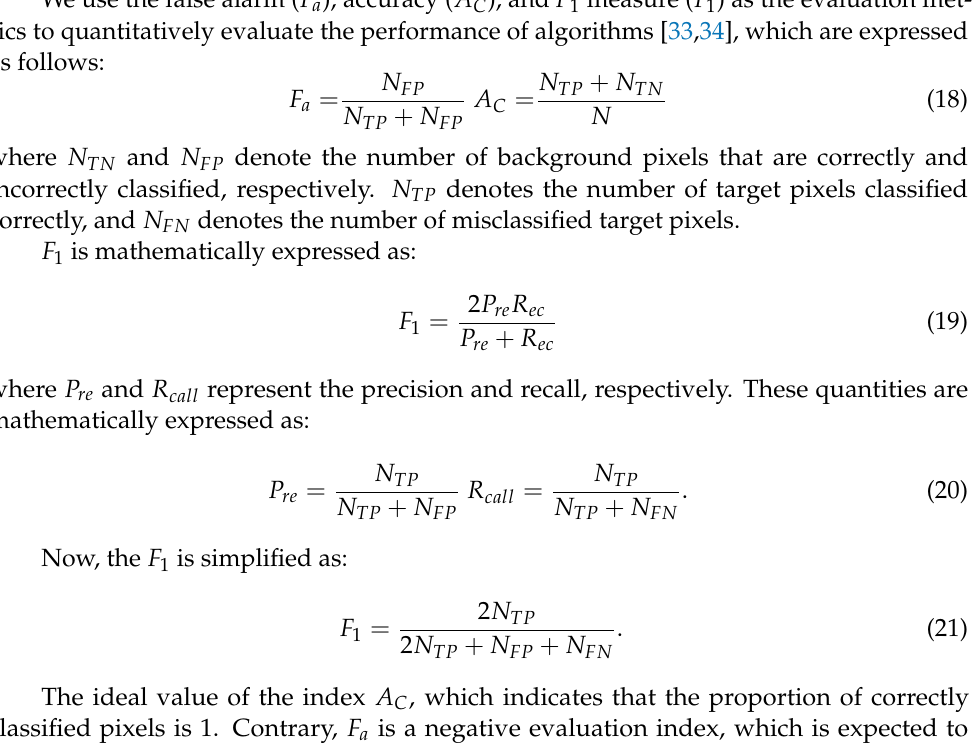
Figure 3. The spectra of different targets and vegetation. To verify the feasibility of the proposed algorithms, we focus on several urban-re- lated scenarios where camouflaged nets appear frequently but are difficult to detect, i.e., (i) Lawn, (ii) Bush and Tree (BT), (iii) Bush and Fountain (BF), and (iv) Unmanned Aerial Vehicle (UAV) scene, as shown in Table 1. The experiment was carried out under different light intensities (1370 – 19,648 lux) to study the effect of spectrum changes caused by light intensity on the algorithm performance. The detection distance is around 20 – 50 m. In ad- dition, the focal lengths of 35 and 16 mm are applied in BF to generate a different field of view (FOV) at the same imaging distance. The integration time varies from 0.1540 to 5 ms.